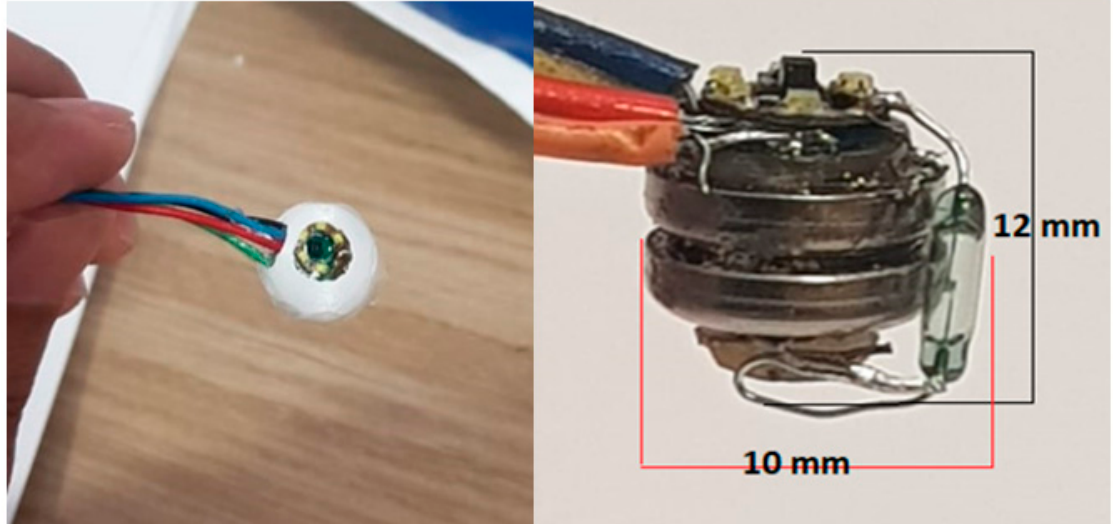
Figure 15. The final shape of the capsule and the capsule core.